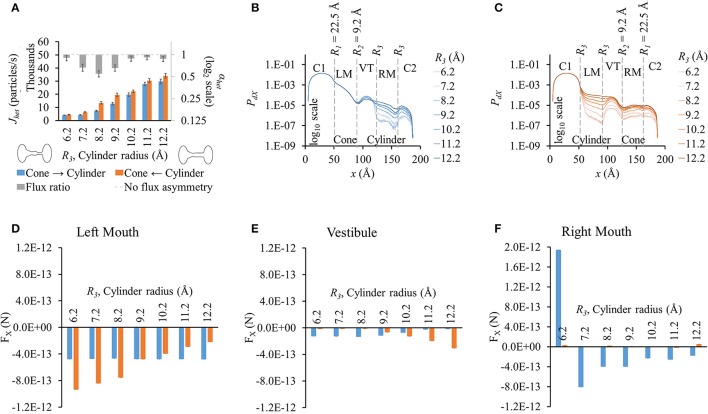
Properties of heterotypic pores with varying cylindrical mouth size (22.5-9.2-R3-R3). (A) LY fluxes increased in both directions as the cylinder section was widened. LY flux ratio rose and then dropped with increasing cylinder mouth size with maximal at R3 = 8.2 Å. (B)
PdX levels remained in the same order up to the mouth of the vestibule in cone to cylinder direction for the different cylinder mouth sizes. Probability profiles almost ran parallel from there on for all cases with probability levels proportional to R3. (C)
PdX levels dropped at the beginning of the cylindrical mouth (left mouth) and mimicked the pore profile up to the vestibule, after which they gently rose. Profiles for different cylinder sizes ran almost parallel. (D–F) Average force per LY particle in (D) left mouth, (E) vestibule, and (F) right mouth. (E) In the cone to cylinder direction, FX in the left mouth was marginally affected by increase in the cylinder mouth size. In the cylinder to cone direction though, FX dropped as the cylindrical mouth was widened. (E) In the vestibule, FX gently dropped in the cone to cylinder direction while rising in the cylinder to cone direction with widening cylindrical mouth. (F) FX magnitudes in the right mouth were larger in the cone to cylinder than cylinder to cone direction with magnitude dropping with increasing R3. FX was negative for all but R3 = 6.2 Å.